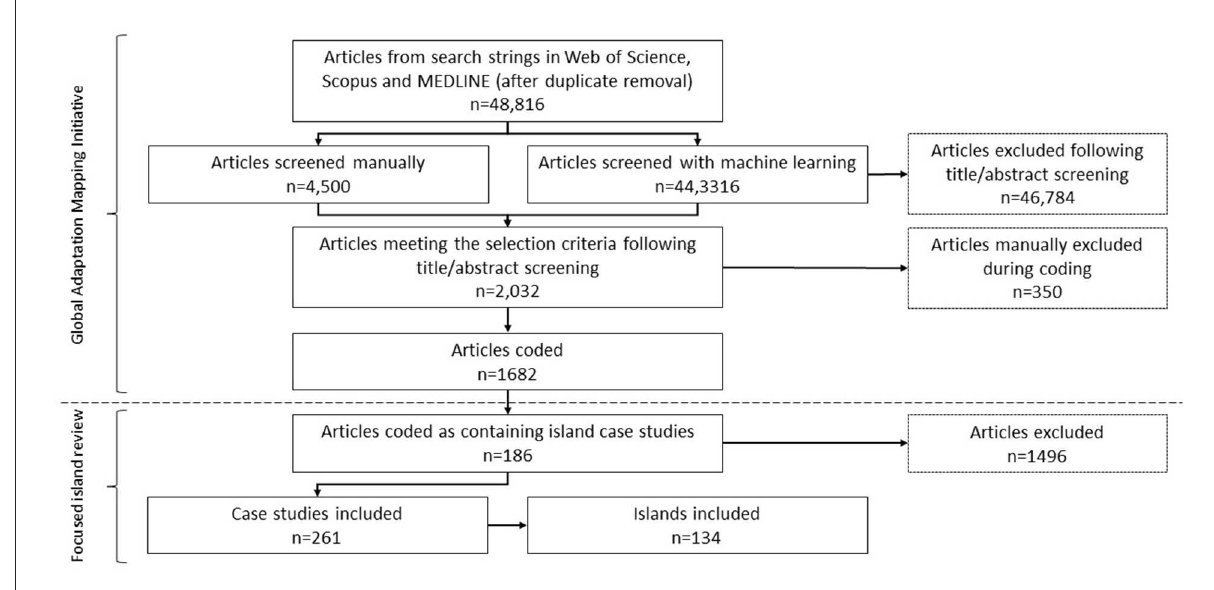
FIGURE1 Systematic review diagram (adapted, after Haddaway et al., 2018).